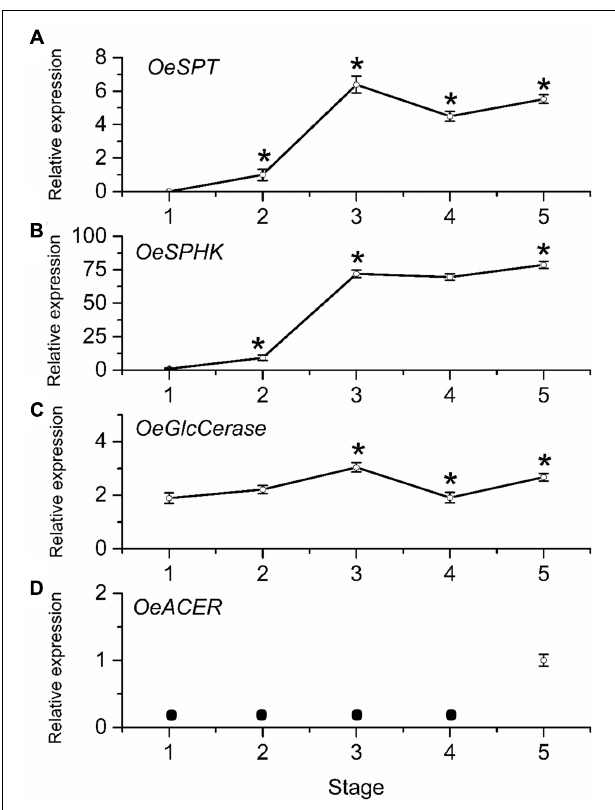
FIGURE 7 | Gene expression of OeSPT (A) , OeSPHK (B) , OeGlcCerase (C) , and OeACER (D) mRNAs in olive fruit during development. Total RNAs were isolated from olive fruit at five different stages of development. Data are the means ± SD of three biological replicates with three technical repeats each and were obtained by qRT-PCR normalized against O. europaea ubiquitine. Statistically significant differences from the preceding point based on unpaired Student’s t -test at P < 0.05 are denoted by asterisks. The mRNA not detected is denoted by a circle ( (cid:32)